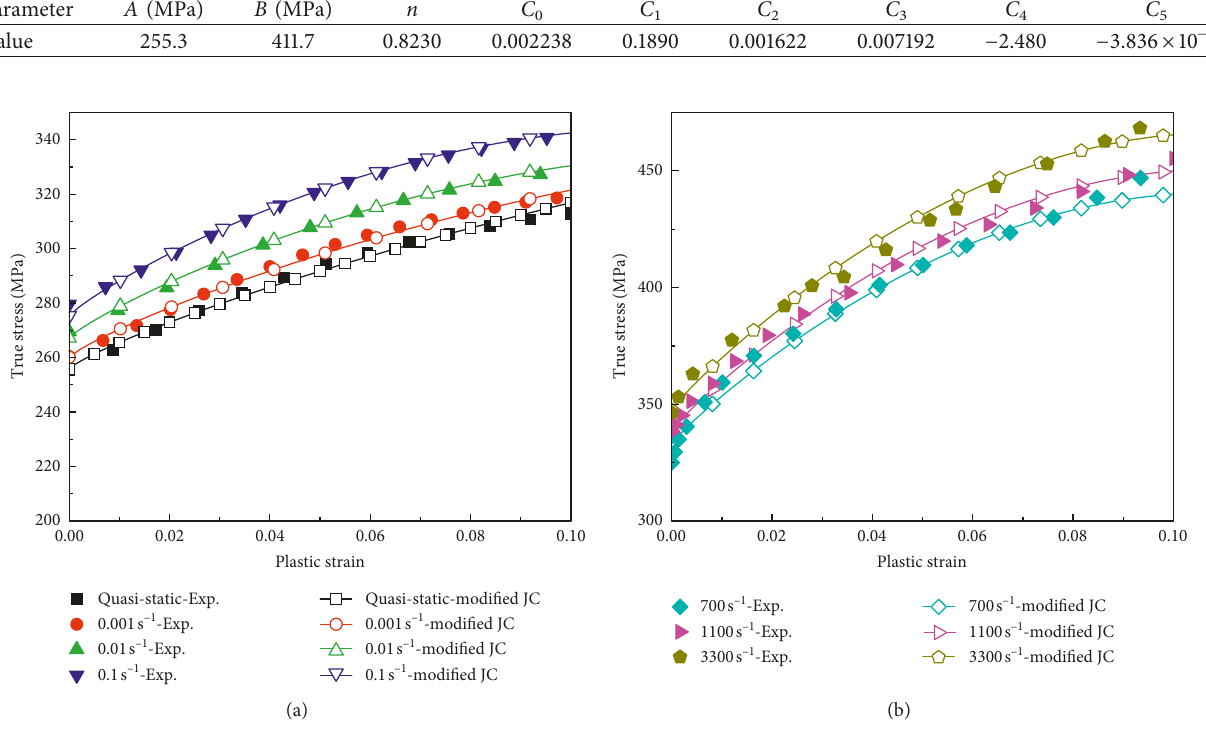
Figure 11: Comparison between the predicted results and experimented results: (a) low strain rates and (b) high strain rates.